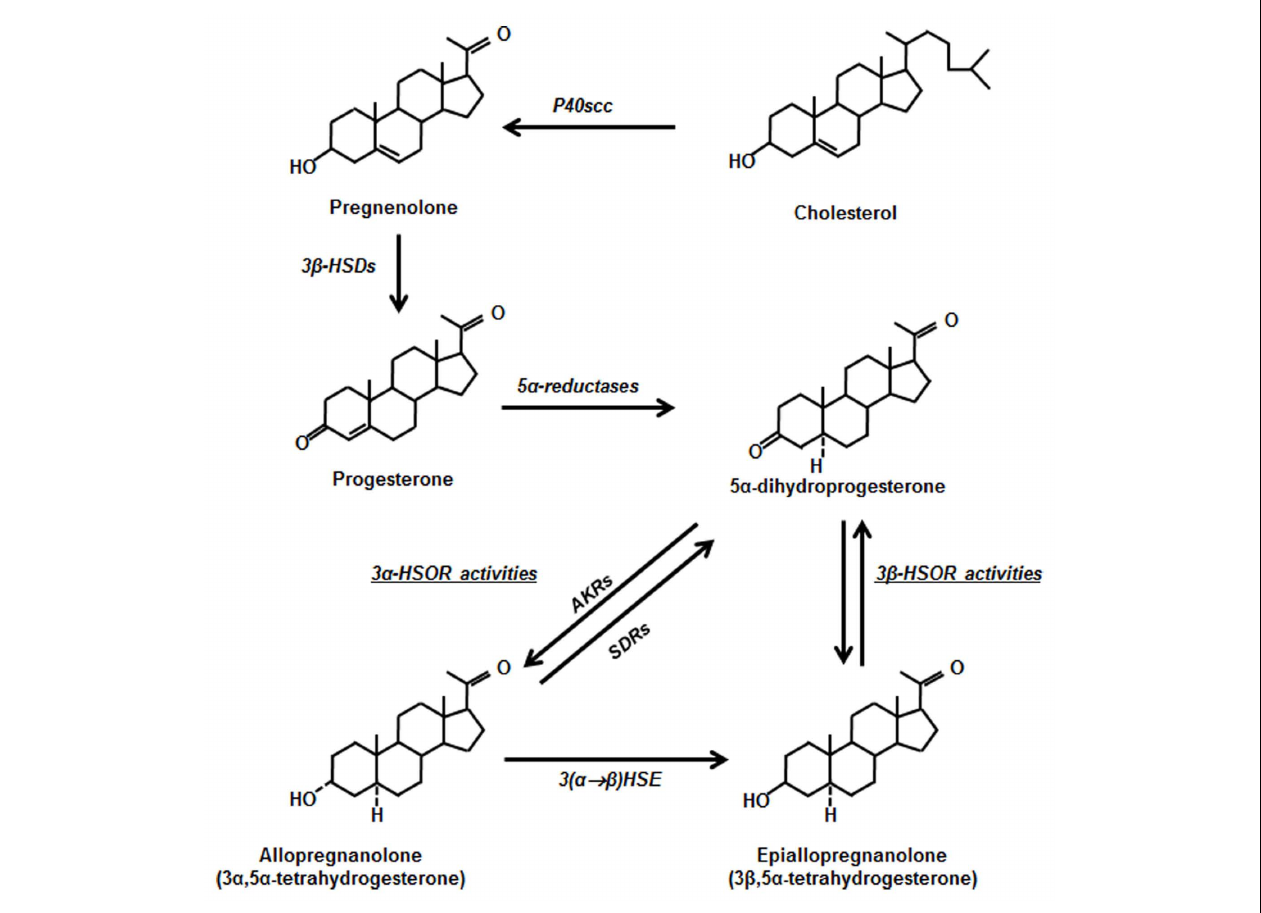
allopregnanolone (3 α ,5 α -tetrahydroprogesterone) by 3 α -hydroxysteroid oxidoreductase (3 α -HSORs) activities, involving aldo-keto reductases (AKRs) converting 5 α -DHP to allopregnanolone and short-chain dehydrogenases/reductases (SDRs), converting allopregnanolone back to 5 α -DHP. A 3( α → β ) hydroxysteroid epimerase (HSE) catalyzes the epimerization of allopregnanolone into